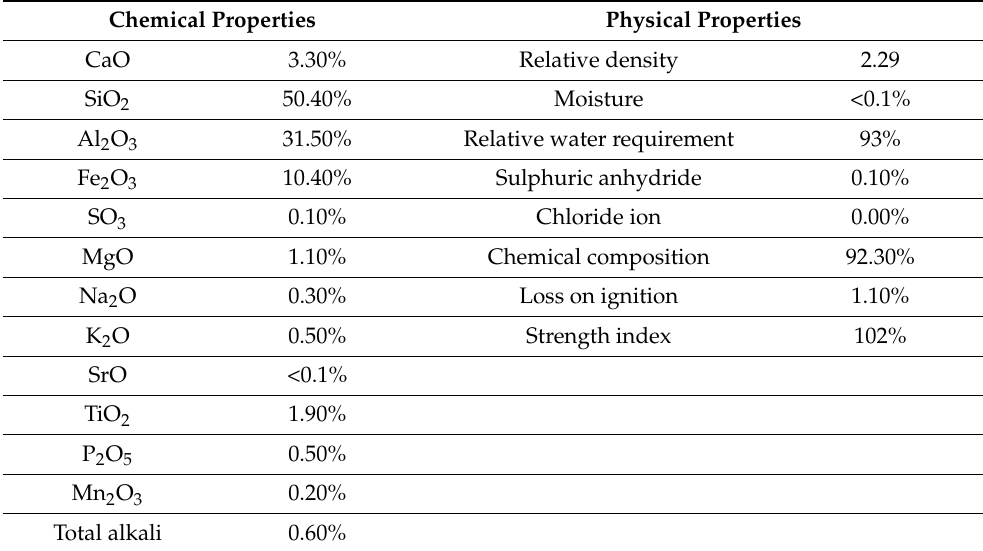
Table 1. Chemical and physical properties of fly